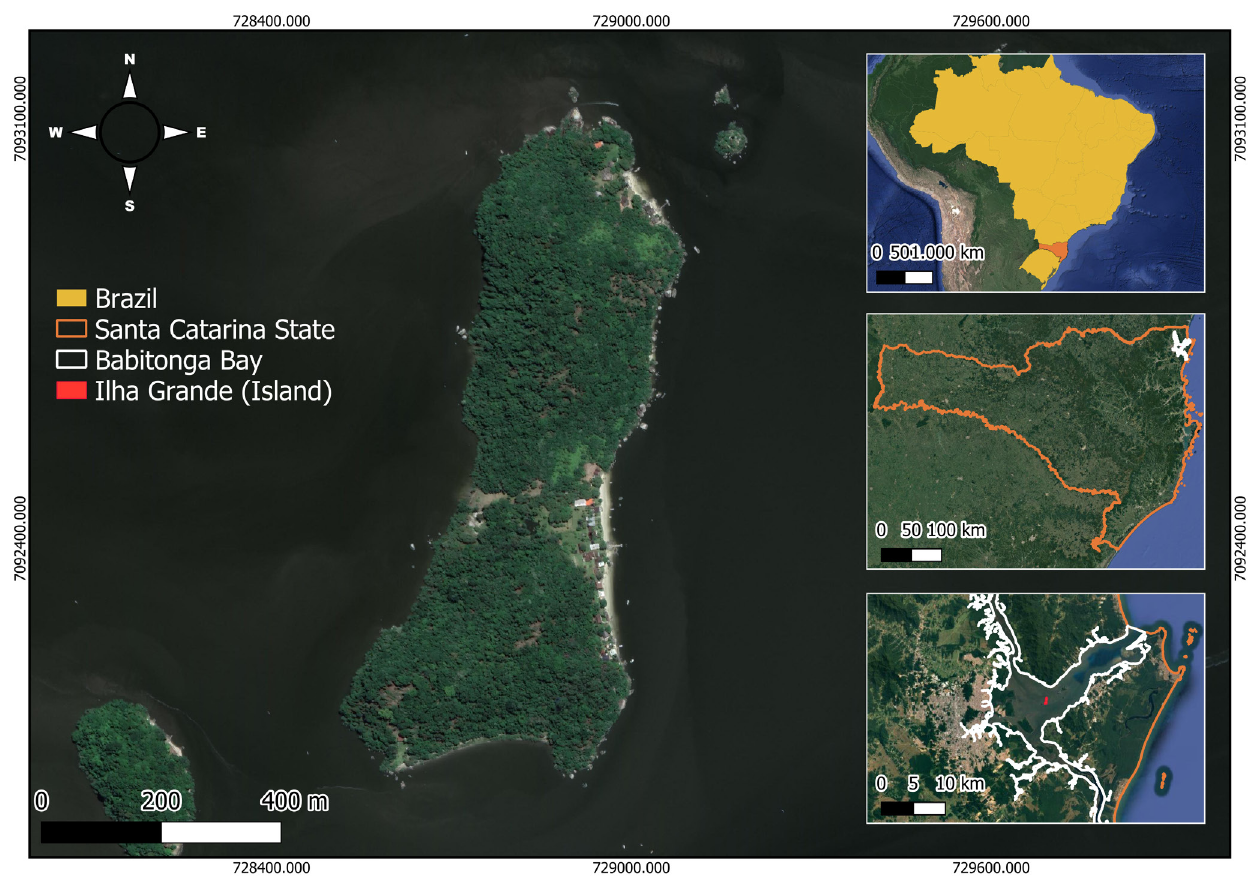
Fig 1 . Map of the location of Ilha Grande, Babitonga Bay, Santa Catarina State. Source: Primary